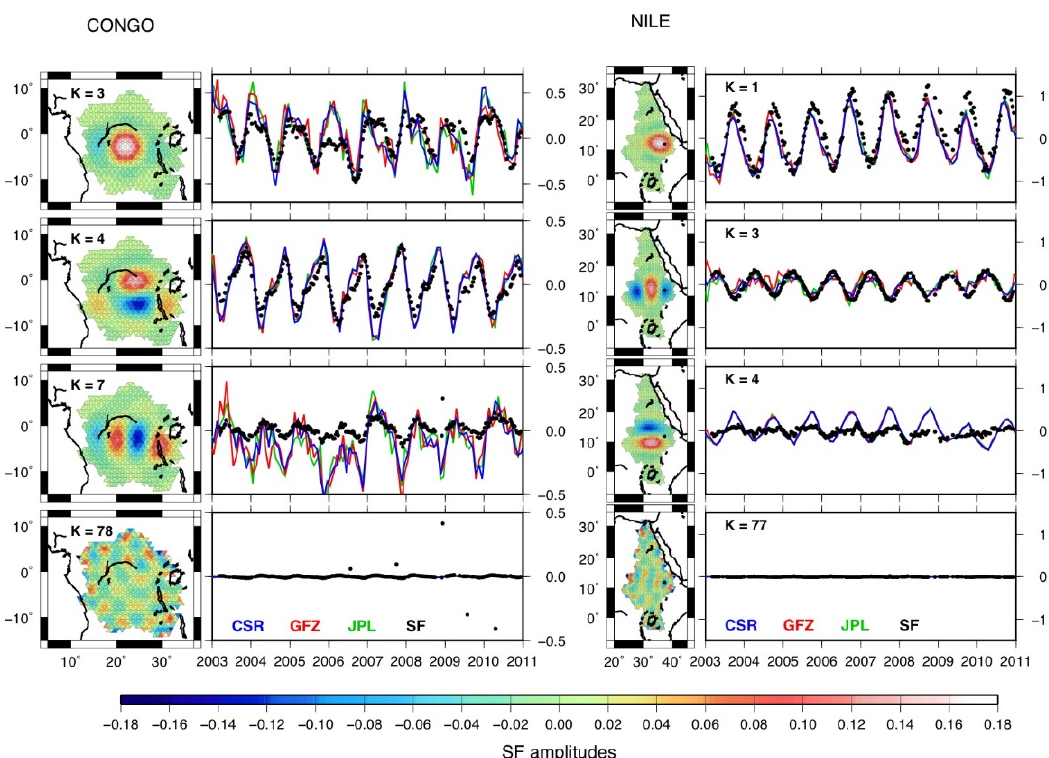
Figure 5. Individual Slepian time series for the Congo (left) and Nile (right) watersheds which are compared to the profiles given by GLDAS (light blue grey), and the SH solutions of the main centers, i.e., CSR (blue), JPL (green), GFZ (red). Units for the SF time series are meters of EWH.